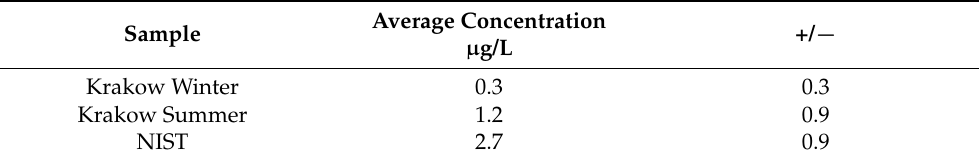
Table 2. Cu content of NIST PM, Krakow winter, and summer dust, obtained by ICP MS analysis. Presented values are average values from measurements of six samples using the method Cu